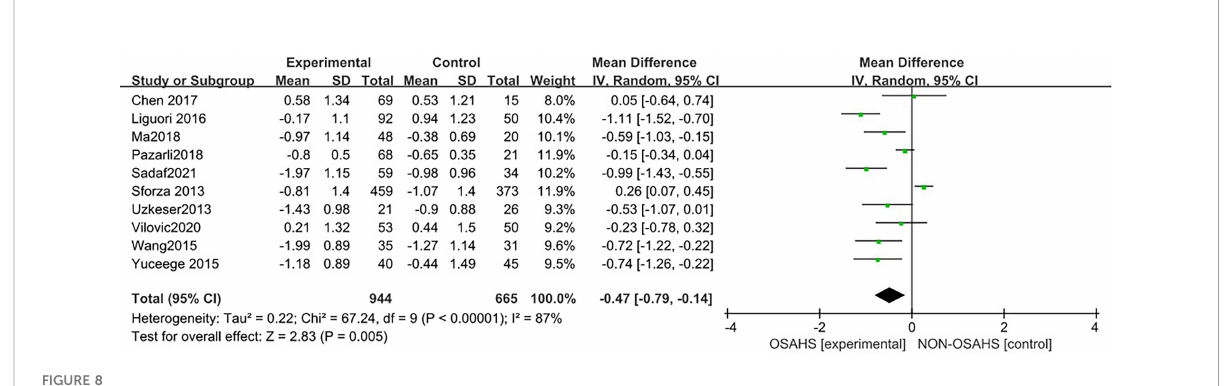
FIGURE 8 Forest plot of lumbar spine T-score between OSAHS group and control group.